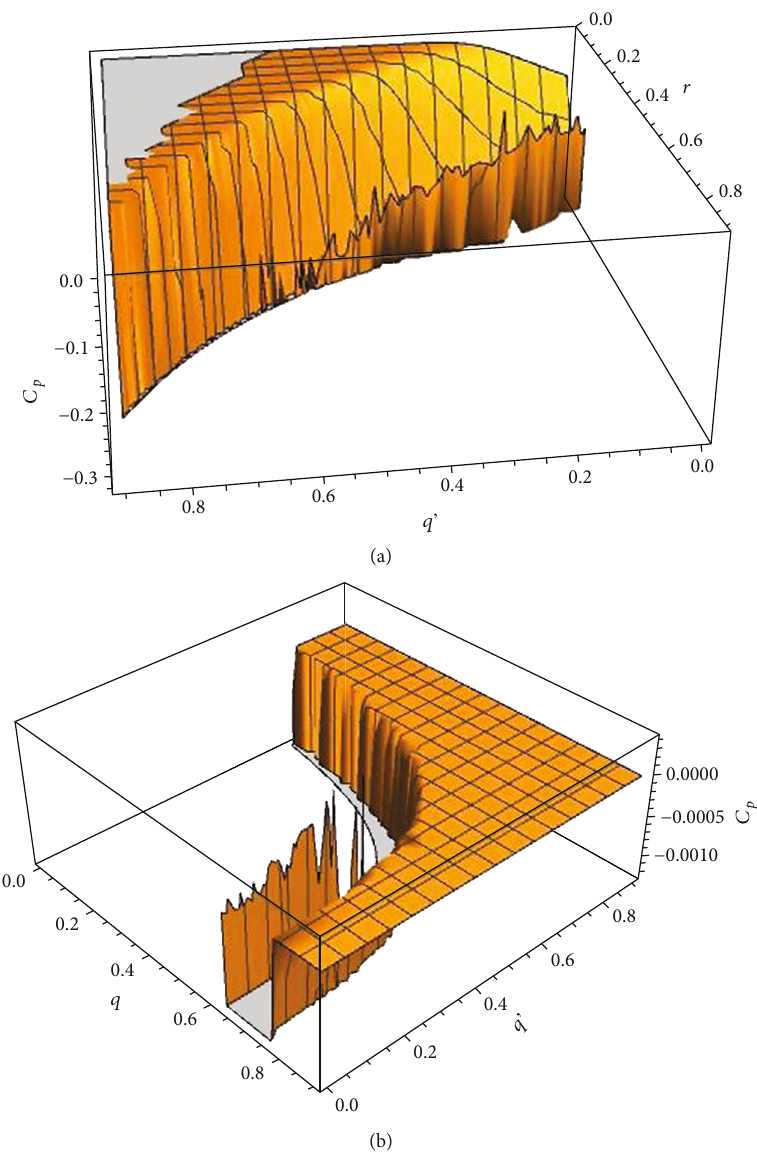
when q , q ′ vary and r P